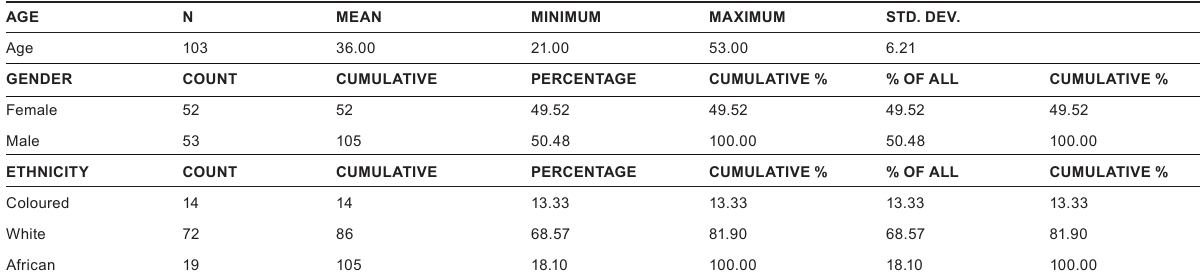
TABLE 1 Descriptive statistics of sample